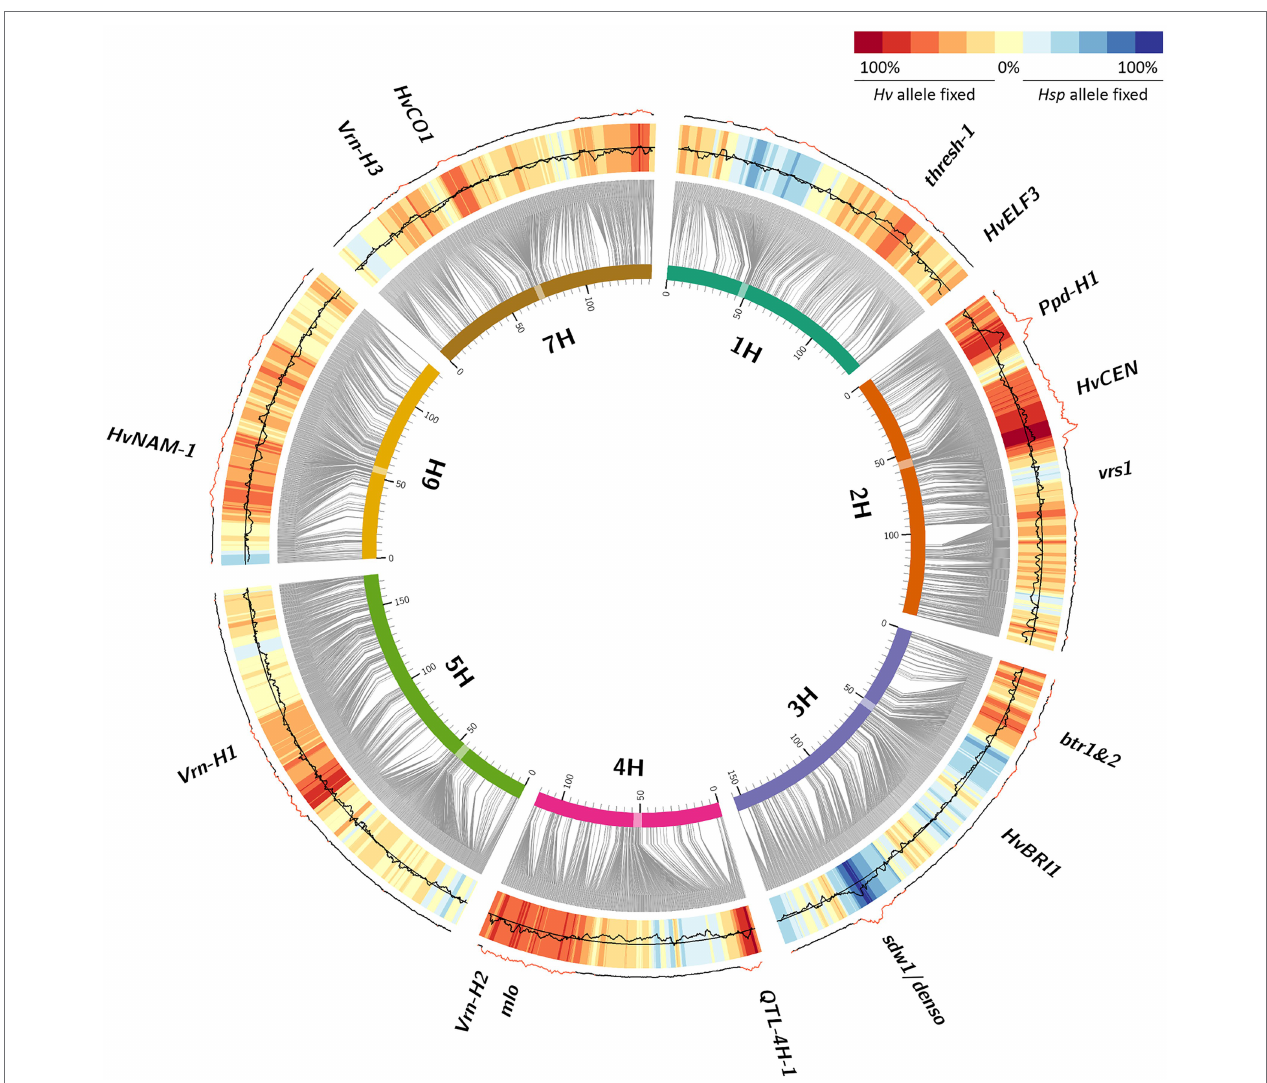
FIGURE 2 | Allele fixation from BC 1 S 3 to BC 1 S 3:8 generations in HEB-25. Barley chromosomes are indicated as inner circle of colored bars; centromeres are highlighted as transparent boxes. Grey connector lines represent the genetic position (in cM) of SNPs on chromosomes based on Maurer et al. (2015). The black line indicates the allele fixation rate (AFR) of SNPs in BC 1 S 3:8 calculated from originally heterozygous HEB-25 lines, summarized over 10 consecutive SNPs. The central reference line indicates the average AFR of 0.486, while the limits of the heat map represent AFRs of 0 (inner) and 1 (outer). AFRs higher than 0.5 represent locus-specific above-average fixation throughout the whole HEB-25 population in BC 1 S 3:8 . The heat map represents the relative fixation direction (RFD), indicating the tendency which allele was fixed in originally heterozygous HEB-25 lines, summarized over 10 consecutive SNPs. Red regions in the outer line indicate significant deviations of RFD from an equal segregation at P (Bonferroni) < 0.01. Candidate genes of barley domestication and flowering time as well as further striking genomic regions are indicated